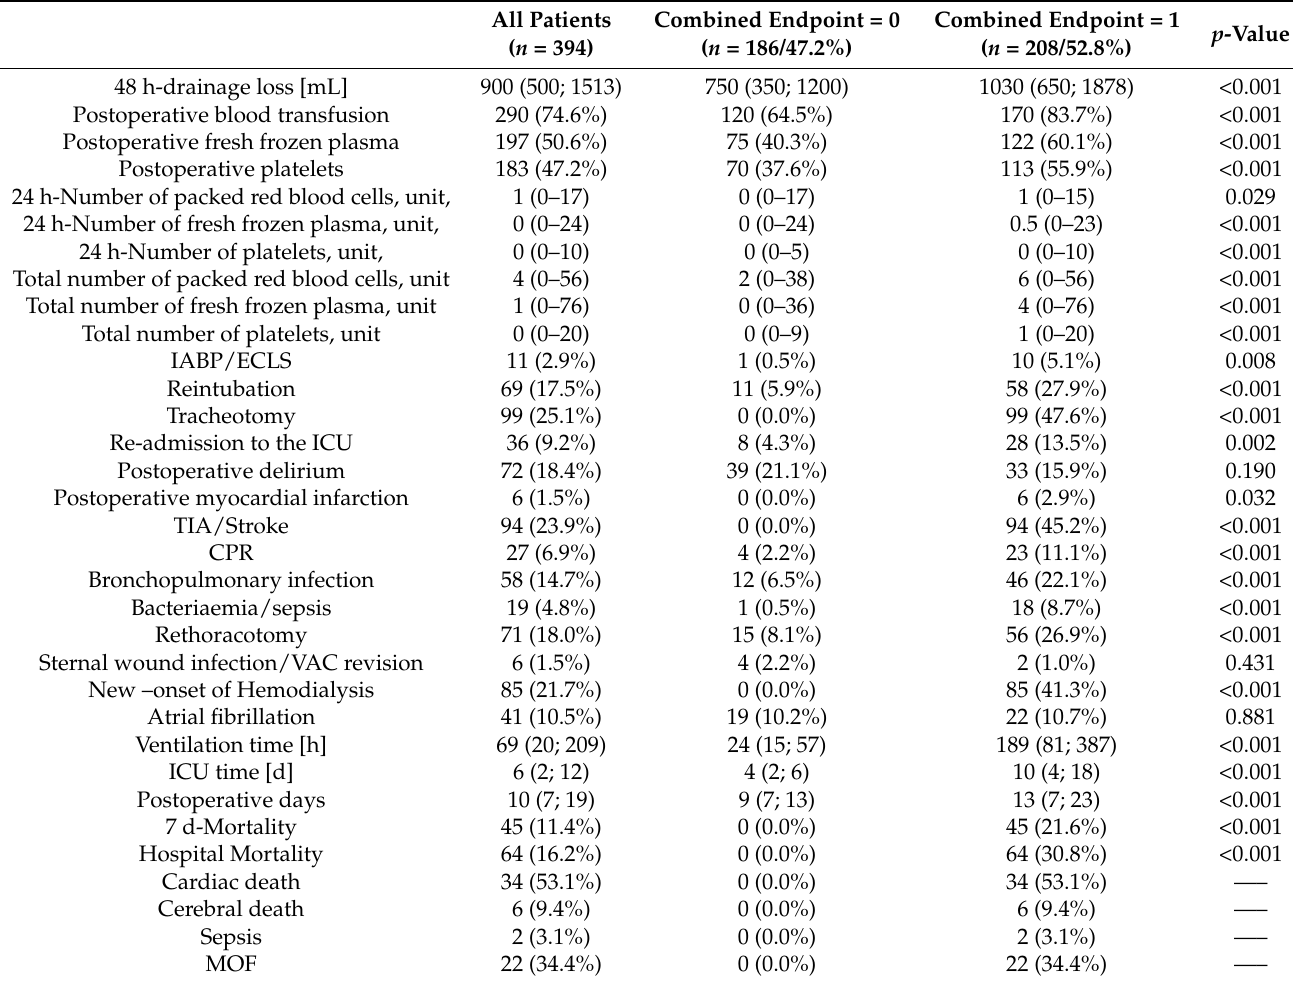
Table 3. Postoperative data and outcomes. All